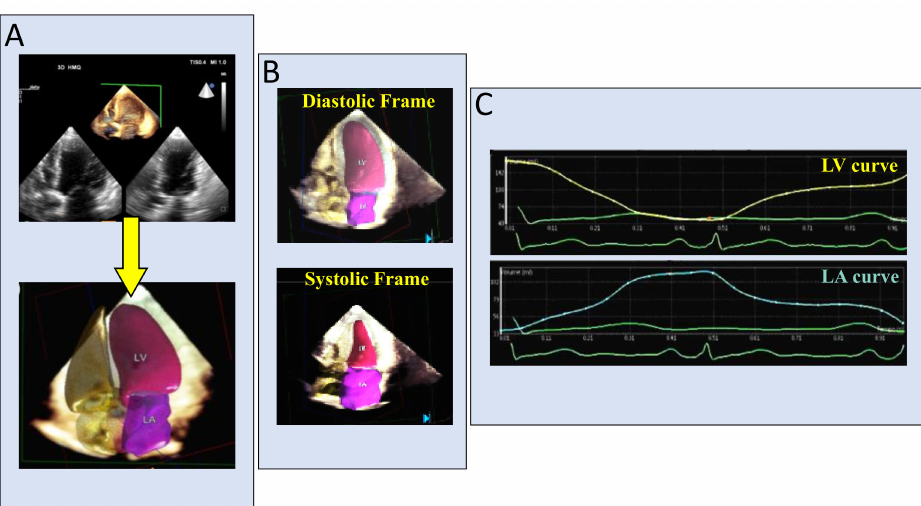
Figure 4. Dynamic automated evaluation of the LV and LA volumes and function. After launching the acquired 3DE dataset ( A ), the examiner has immediately on the display LV and LA with automated recognition of the 2 cavities ( B ) and LV/LA reciprocal volumetric changes, throughout the cardiac cycle, with all measurements and functional curves ( C